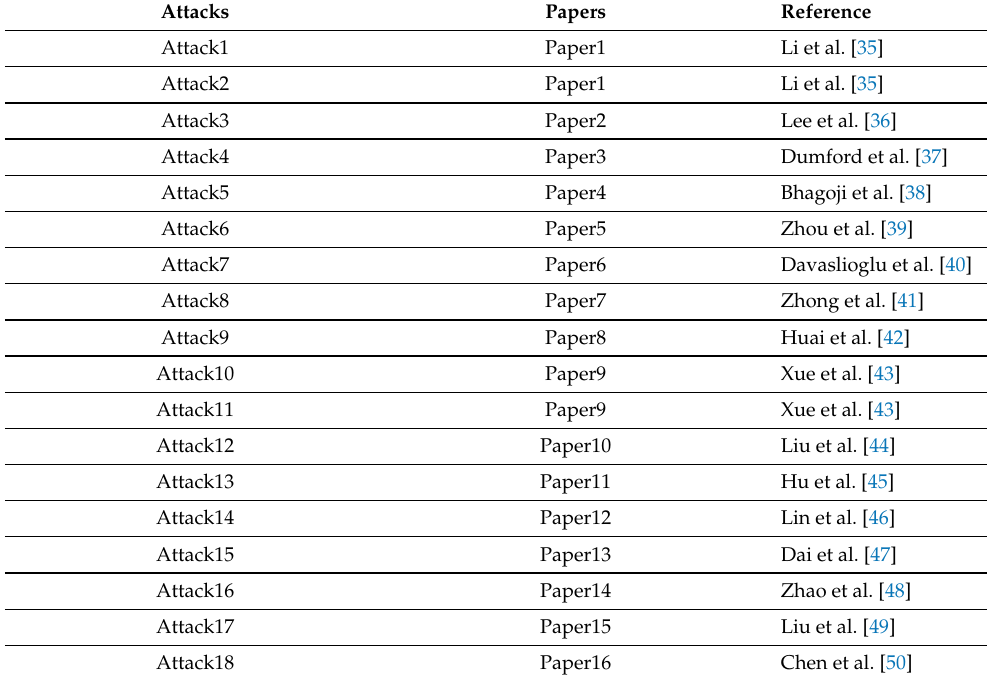
Table 11. A list of individuals in